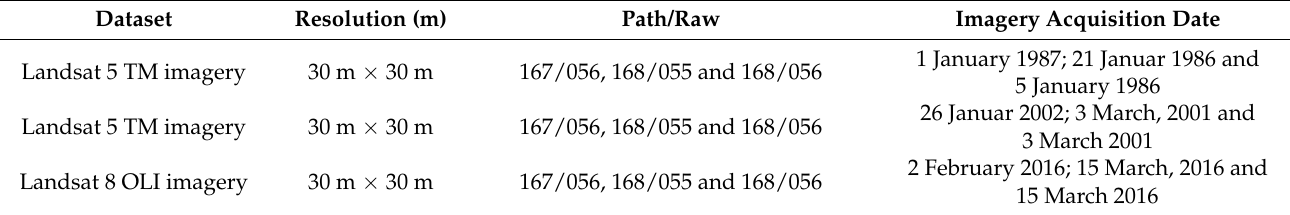
Table 1. Description of Landsat